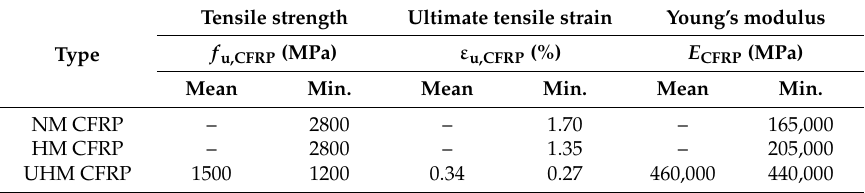
Table 3. Mechanical properties of the CFRP plates (from the manufacturers’ data sheet).